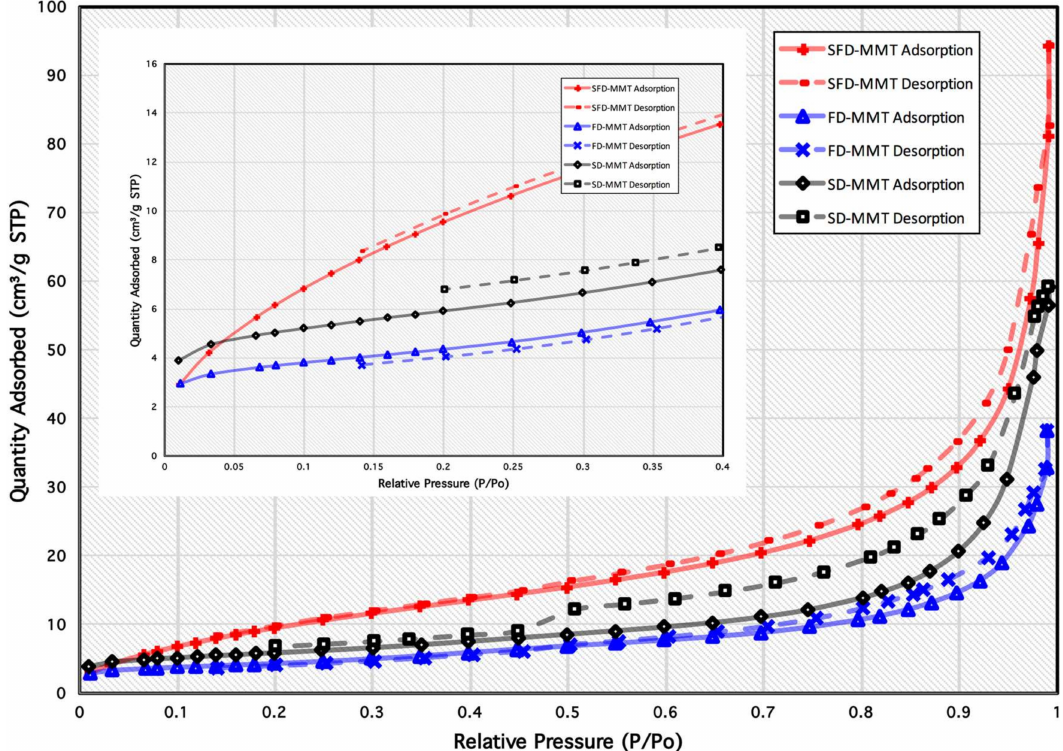
Figure 3. Nitrogen adsorption/desorption isotherms at 77 K of SD-MMT, FD-MMT and SFD-MMT